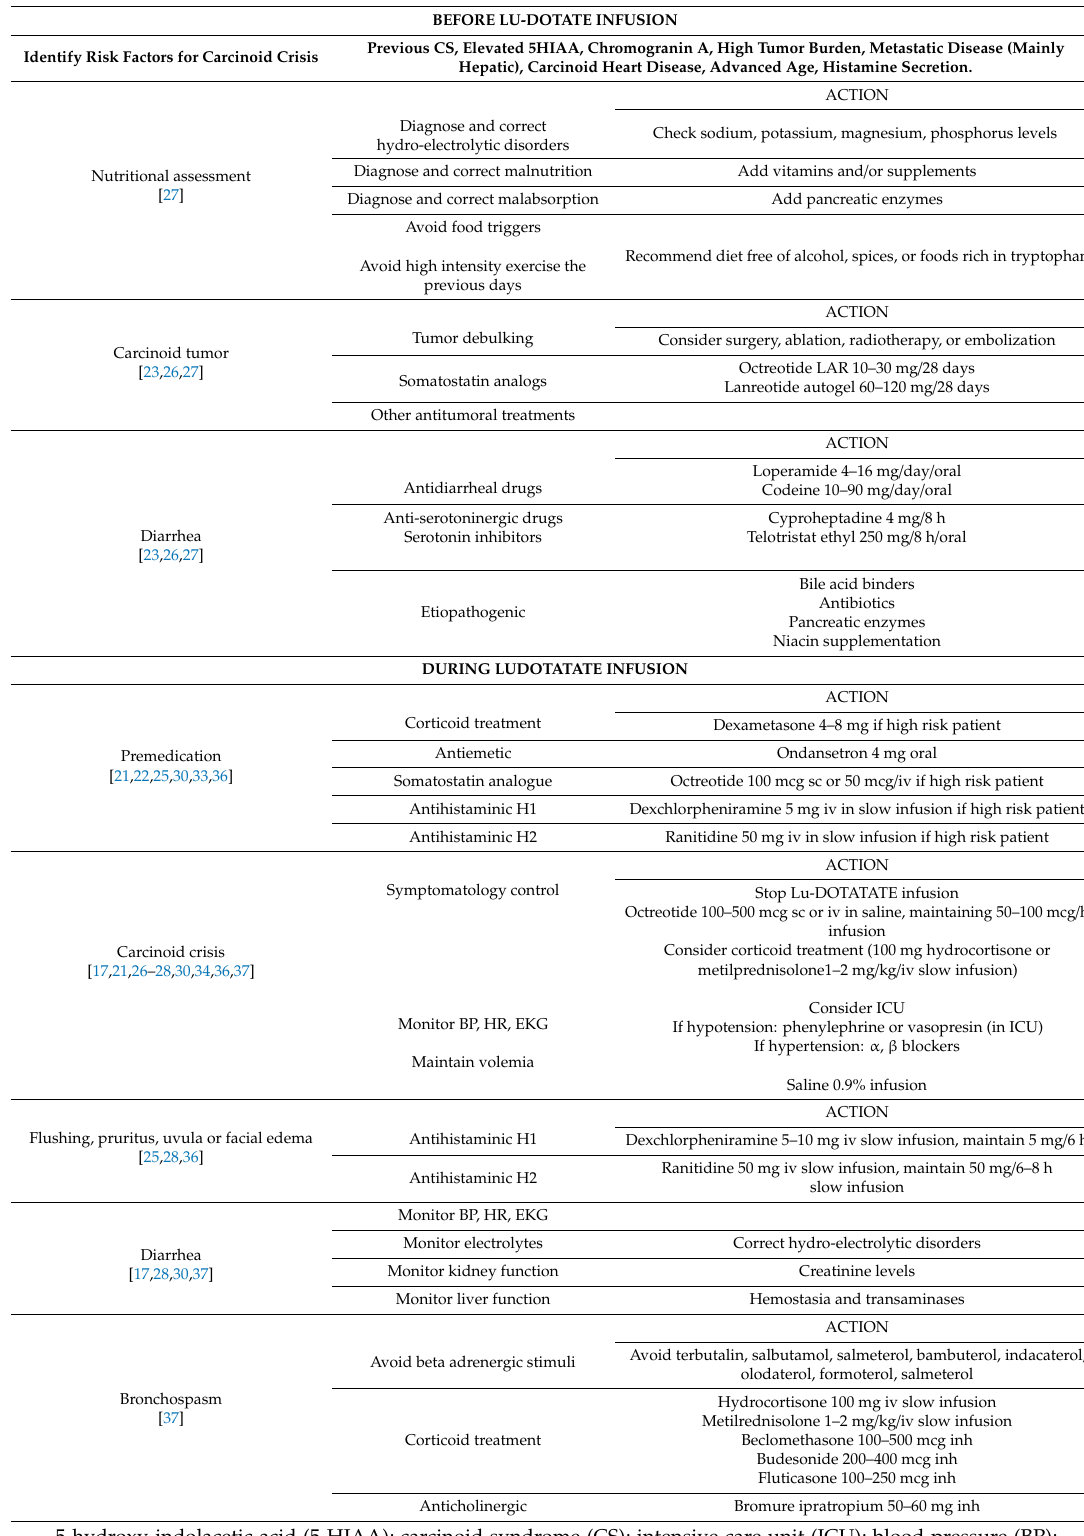
Table 3. General measures for prevention and management of carcinoid